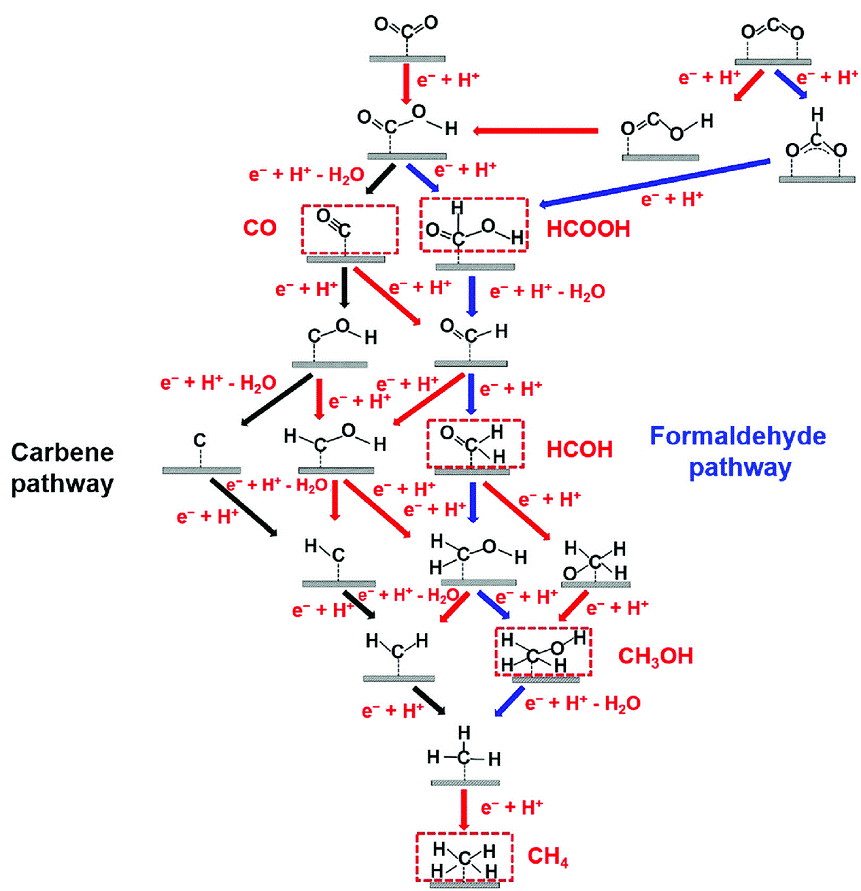
Figure 5. The possible pathways of photocatalytic CO 2 reduction to CH 4 or other hydrocarbon fuels on the surface of photocatalysts, retrieved from